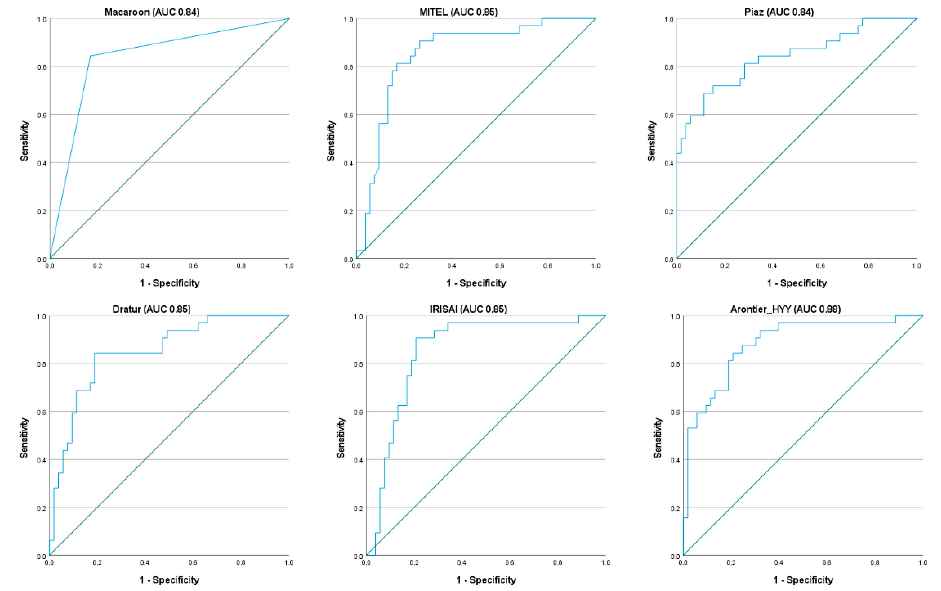
Figure 10. ROC curves for the methods proposed by the six best teams in the subset of equivocal cases by IHC (score of 2+).